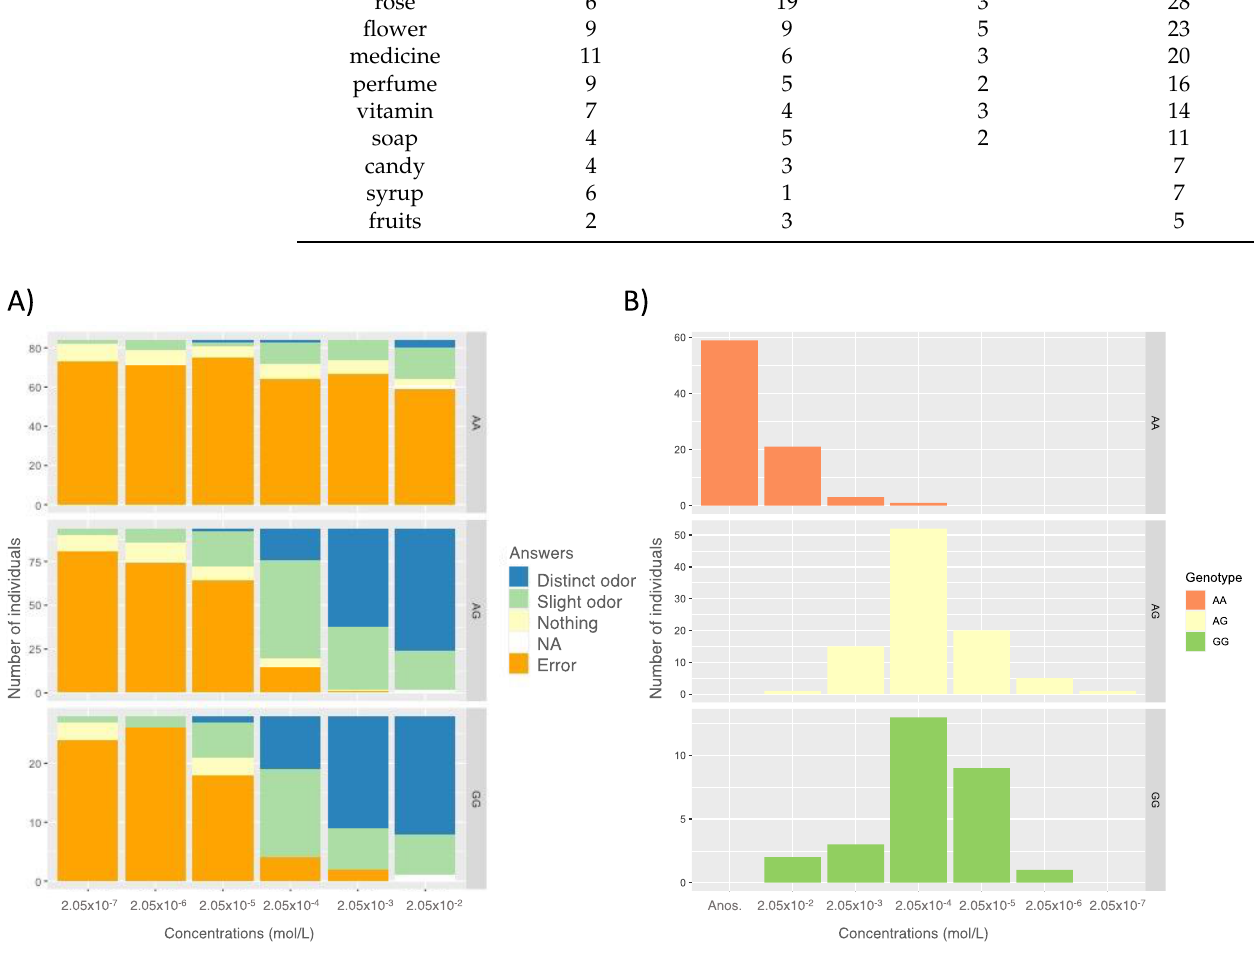
Figure 2. Detection of beta-ionone according to odor concentration and genotype. (From the 235 initial participants only the 206 who have performed the threshold detection task are represented here.) ( A) Percentage of participants choosing the wrong vial (Error) and evaluating the vial they selected in the detection threshold test as smelling nothing, a slight odor, or a distinct odor, for each concentration (mol/L) and according to their genotype. NA represents the proportion of participants who selected the correct vial but did not rate it. ( B ) Computed detection threshold for beta-ionone according to genotype. (Anos = anosmic to beta-ionone). Table 2. Ability to detect beta-ionone according to (i) the participants’ genotype (column); (ii) the chromosome origins (column) (AFR-AFR: two loci with African local ancestry; AFR-EAS: one locus with African local ancestry and one with East Asian ancestry; EAS-EAS: two loci with East Asian local ancestry) (from the 235 initial participants only the 206 who have performed the threshold detection task are represented here).